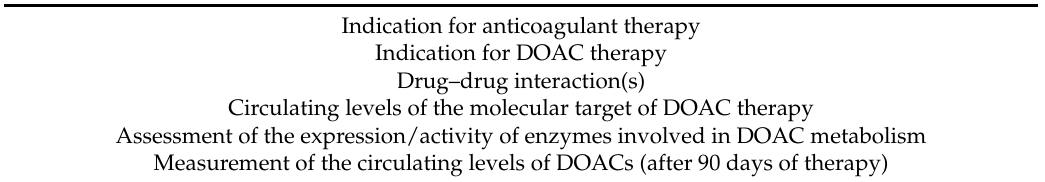
Table 1. Factors involved in the efficacy and effectiveness of direct oral anticoagulant (DOAC) therapy. Indication for anticoagulant